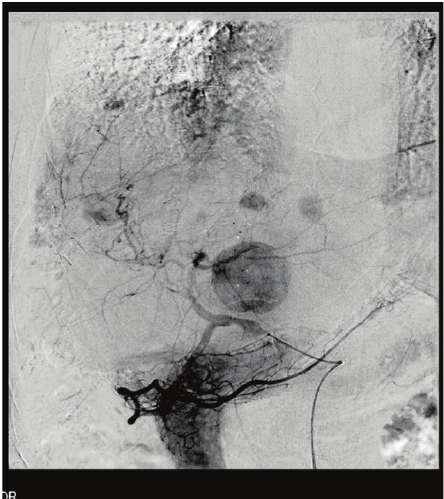
Figure 7: Multiple hypervascular hepatic lesions.